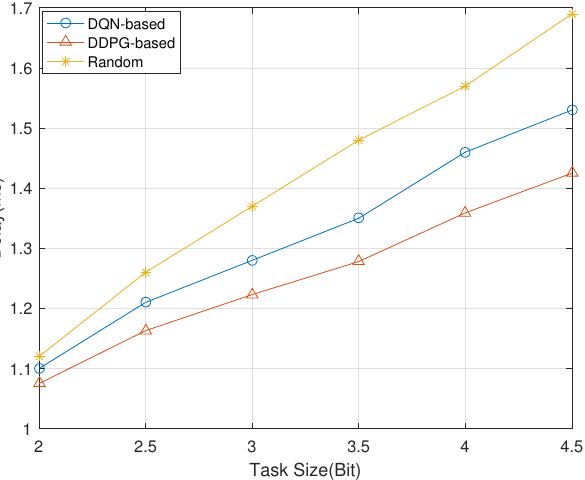
Figure 8. The delay comparison under different task sizes, where the red curve represents the delay of the DDPG-based computational offloading paradigm, the blue curve represents the delay of the DQN-based computational offloading paradigm, and the yellow curve represents the delay of the “Random”